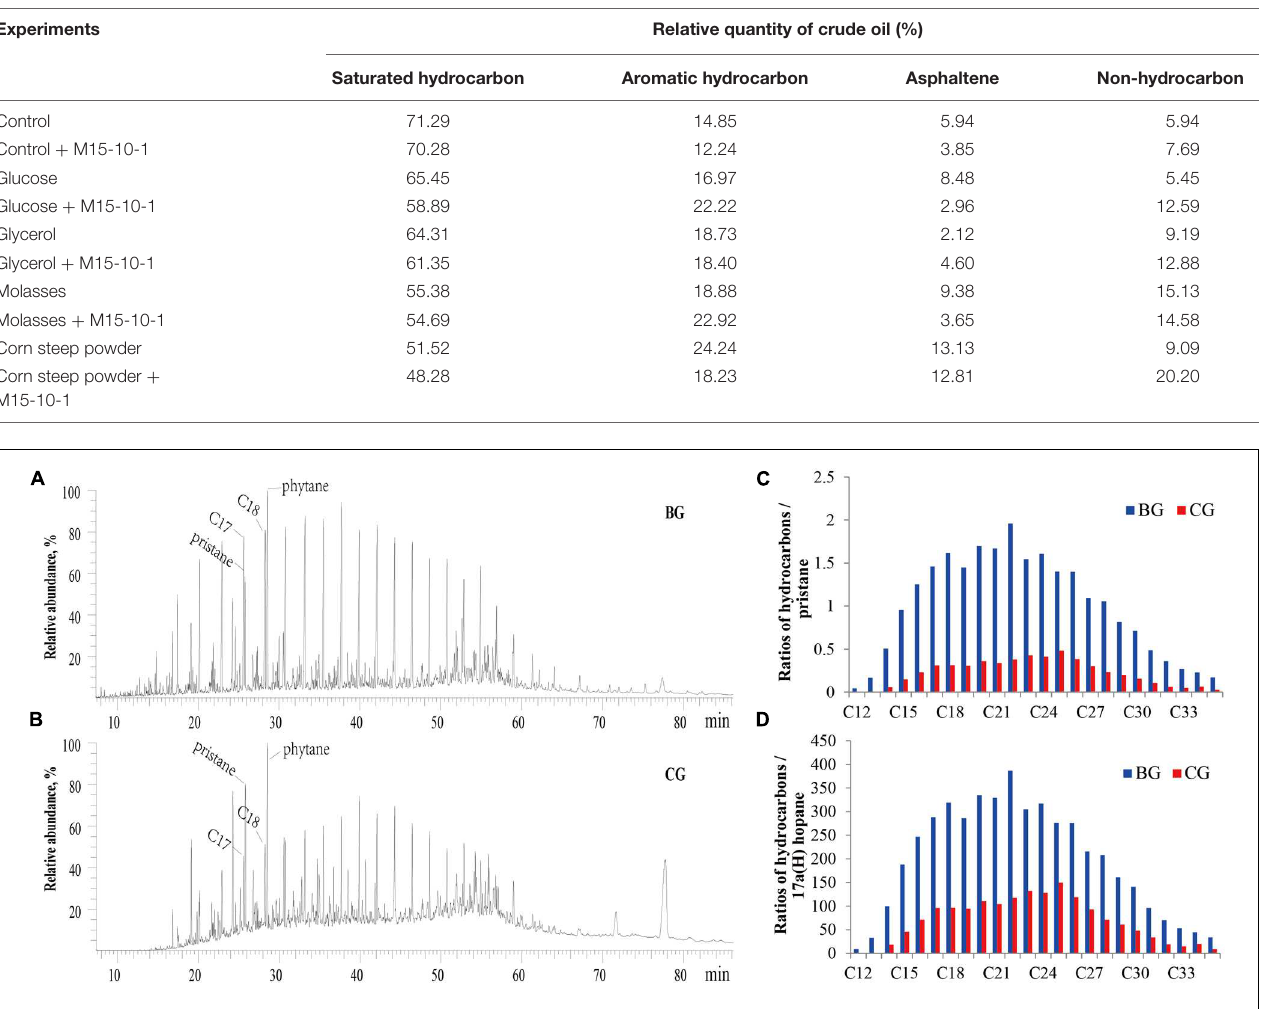
FIGURE 7 | Gas chromatography profile of total hydrocarbon (A,B) and the relative ratios of different chain-length hydrocarbons to pristine or 17 α (H)-hopane in crude oil (C,D) during stimulation with nutrients or in combination with Bacillus subtilis M15-10-1. BG: microcosm containing glucose; CG: microcosm containing glucose and Bacillus subtilis